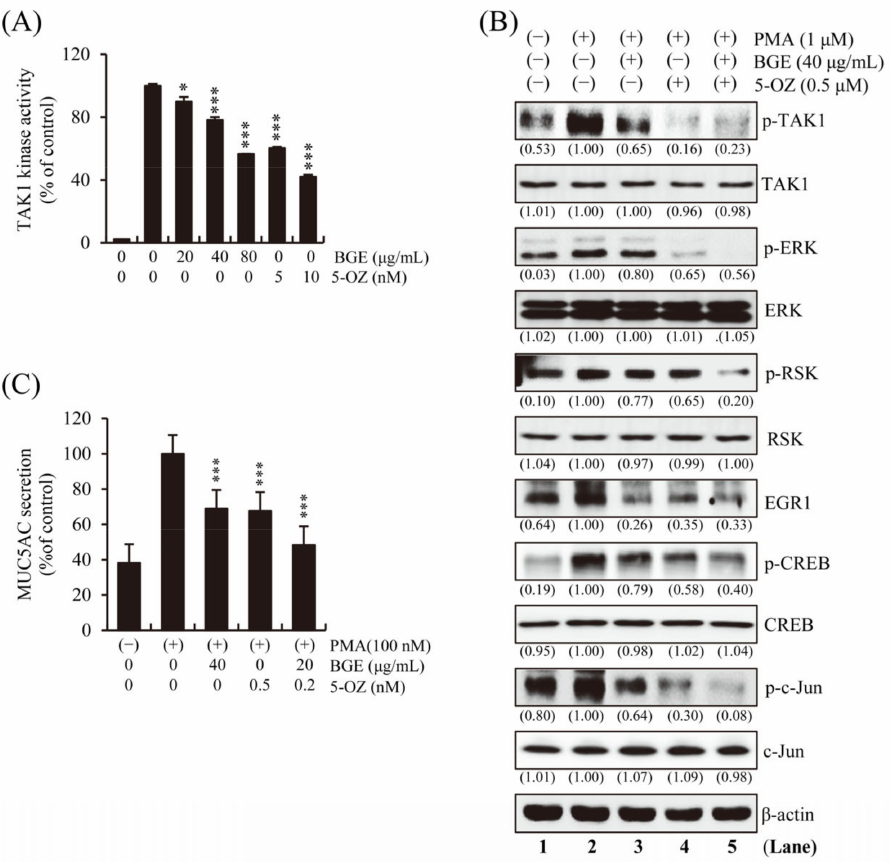
Figure 5. Effects of BGE on TAKI activity in NCI-H292 cells. ( A ) In vitro TAK1 enzymatic kinase assay was performed. Bar graphs represent means ± S.D. in triplicate in one representative experiment from three independent experiments (* p < 0.05 and *** p < 0.001 compared with TAK1 enzyme alone). ( B ) The cells were pre-treated with indicated concentrations of BGE and/or 5-OZ (a TAK1 inhibitor) for 2 h, and subsequently treated with PMA (1 µ M) for 30 min. Total cell lysates were assayed by Western blotting using antibodies against p-TAK1, TAK1, p-ERK, ERK, p-RSK, RSK, p-CREB, CREB, EGR1, p-c-jun and c-jun. B-actin was used as a loading control. The numbers underneath the bands indicate the relative band intensity to controls, which were treated with PMA alone. The lane numbers are indicated below the western blot image. ( C ) MUC5AC secretion was determined using ELISA kit. Cells were pre-treated with respective concentrations of the treatments for 2 h and subsequently exposed to PMA (100 nM) for 16 h. The bar graph presents means ± SD of three independent experiments (*** p < 0.001 compared with the PMA alone). Western blotting was independently performed